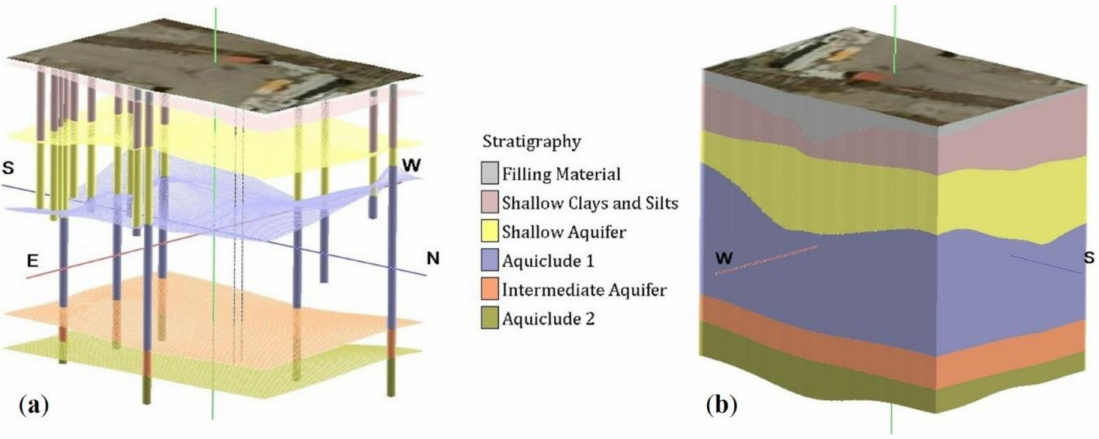
Figure 3. ( a ) Boreholes, stratigraphic contacts, and ( b ) geological model of the pilot test area in